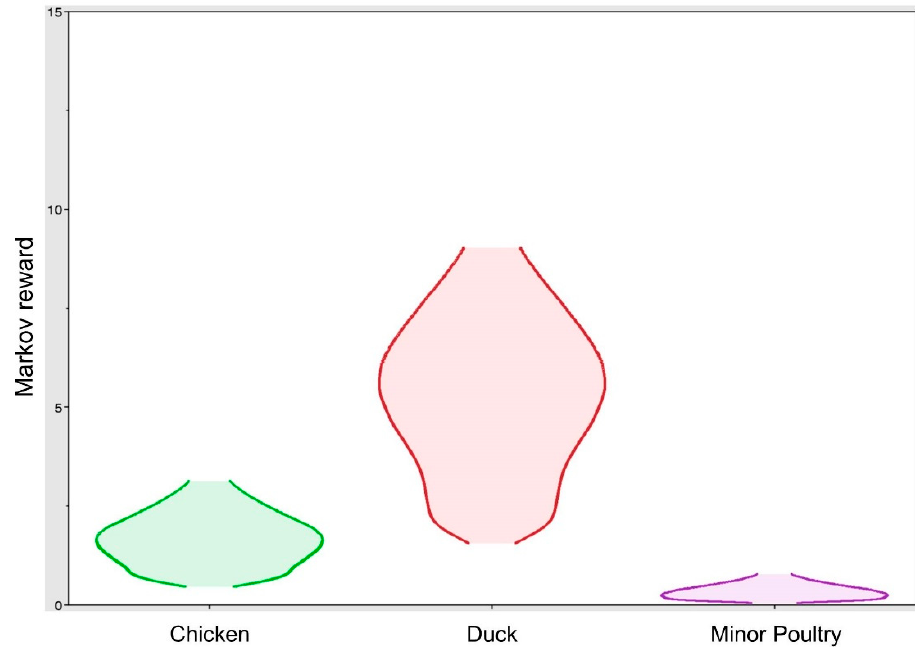
Figure 5. Markov reward time for each poultry species in South Korea. The violin plot of each poultry species ( X -axis) depicts density distribution of the total time spent in years ( Y -axis); domestic ducks: 5.53 (95% BCI: 1.62–9.32), chickens: 1.75 (95% BCI: 0.45–3.18), and minor poultry: 0.37 (95% BCI: